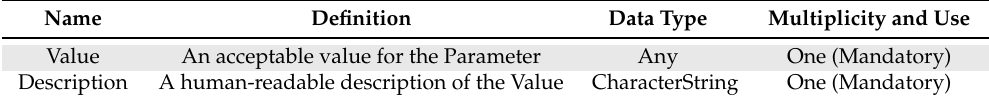
Table 6. Properties of the Value .